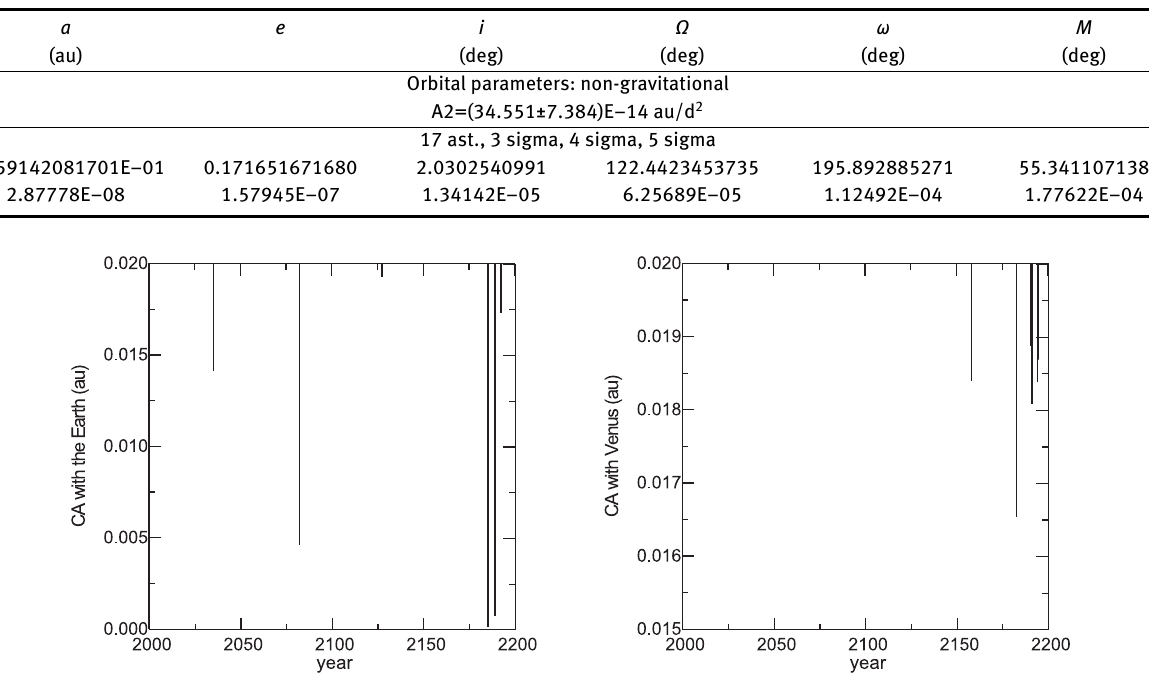
Figure 1. Close approaches of the asteroid 2001 BB16 with the Earth and with Venus.